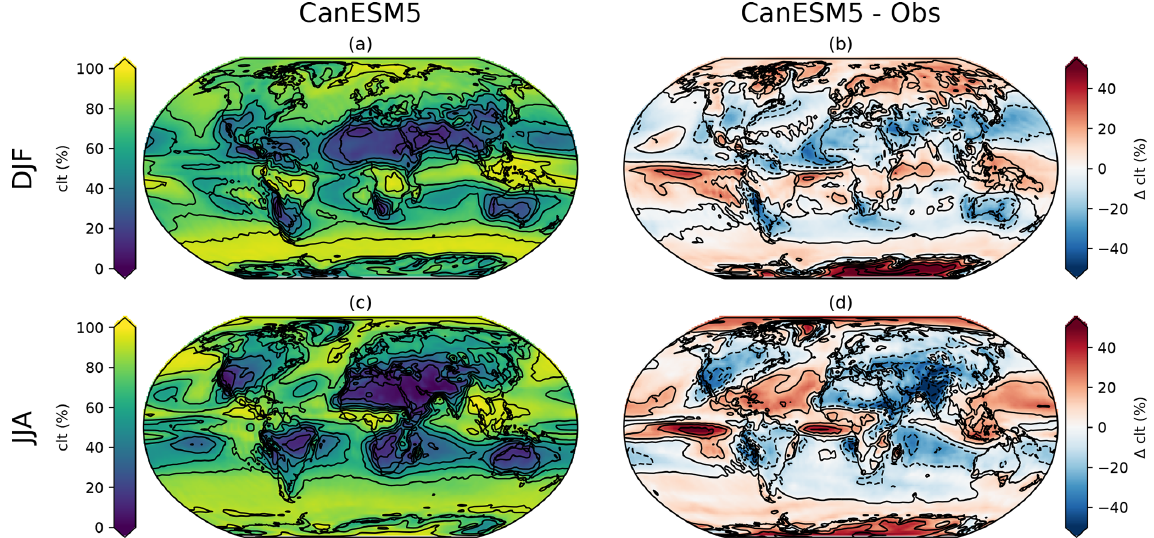
Figure 8. Cloud fraction in CanESM5 (a, c) and their bias with respect to International Satellite Cloud Climatology Project H series (ISCCP- H) satellite-based observations (b, d) shown for the DJF (a, b) and JJA (c, d)